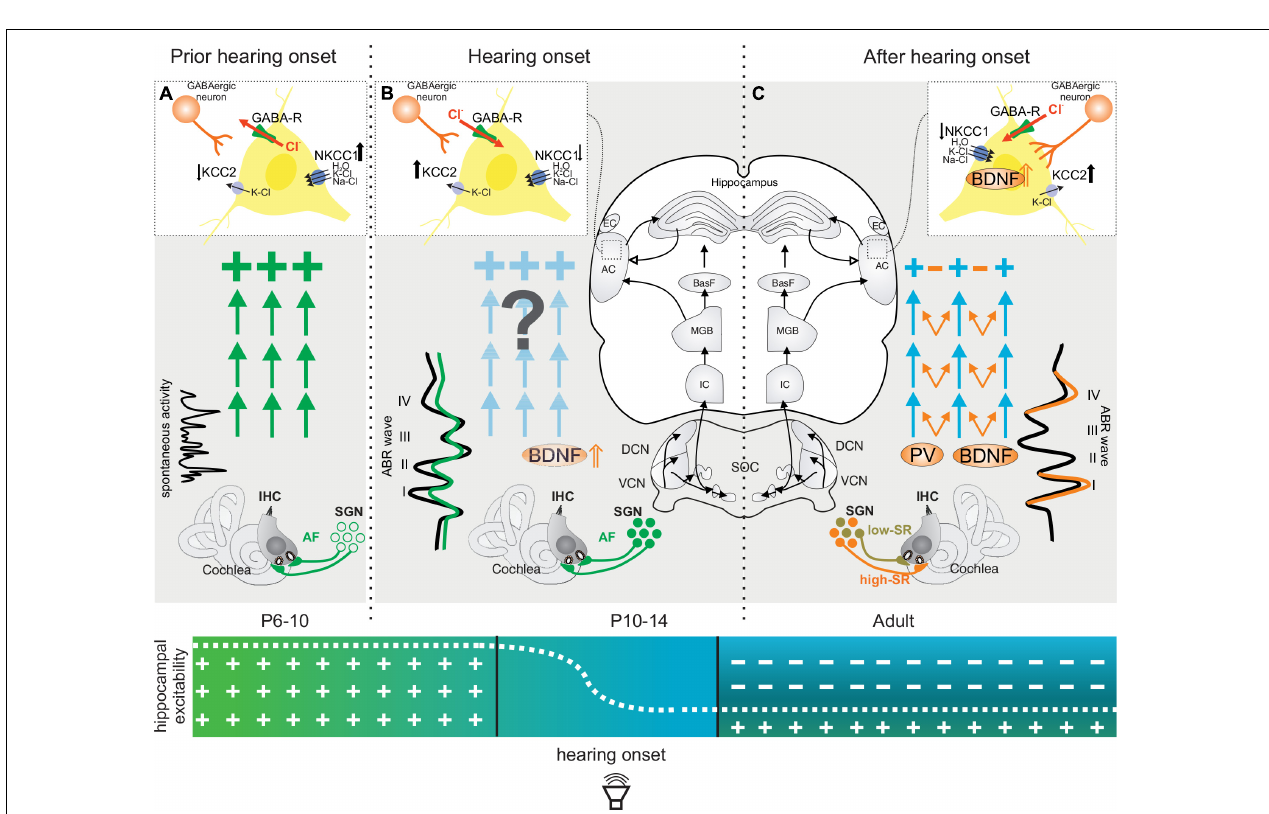
FIGURE 1 | Maturation of neuronal inhibitory circuits in the auditory system prior to (A) , during (B) , and after (C) hearing onset. (A) Prior to hearing onset, when GABAergic neurons (inset, light red cell) do not yet contact target cells, GABA-responsive pyramidal neurons favor a chloride efflux (inset, red arrow) and thereby a depolarization of GABA-responsive neurons. A high intracellular chloride concentration in these cells is supported by low levels of neuronal potassium chloride co-transporter type 2 ( ↓ KCC2) and elevated sodium-potassium-chloride co-transporter type 1 (NKCC1 ↑ ). At this time, an initial hyper-excitability dominates (large green crosses) and IHCs show only spontaneous firing. (B) Shortly before hearing onset, BDNF is upregulated in the cochlea (Wiechers et al., 1999) and a switch in the effect of GABA from depolarizing to hyperpolarizing occurs (Lohrke et al., 2005) ( B inset, GABAergic neuron and red inward arrow), accompanied by a reduced NKCC1 ↓ and an increased KCC2 ↑ expression ( B , inset). This may already be driven by auditory input (Shibata et al., 2004) ( B , green ABR wave on the left). (C) A switch of the GABA action from excitatory/depolarizing to inhibitory/hyperpolarizing is initiated in projection neurons after hearing onset, (P10–14). This time period parallels the maturation of the high-SR ( C , orange fiber) and low-SR auditory nerve fibers ( C , green fibers). The switch of GABA from excitatory to inhibitory ( B,C , inset) is initiated by an upregulation of KCC2 ↑ after hearing onset, (P10–14). KCC2 promotes a lower concentration of intracellular chloride in